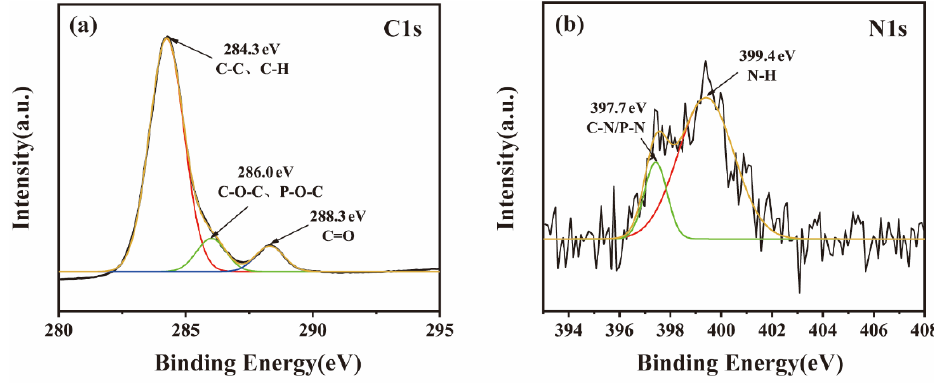
Figure 8. C1s ( a ), N1s ( b ), O1s ( c ), and P2p ( d ) spectra of residual char of FREP-7.5.